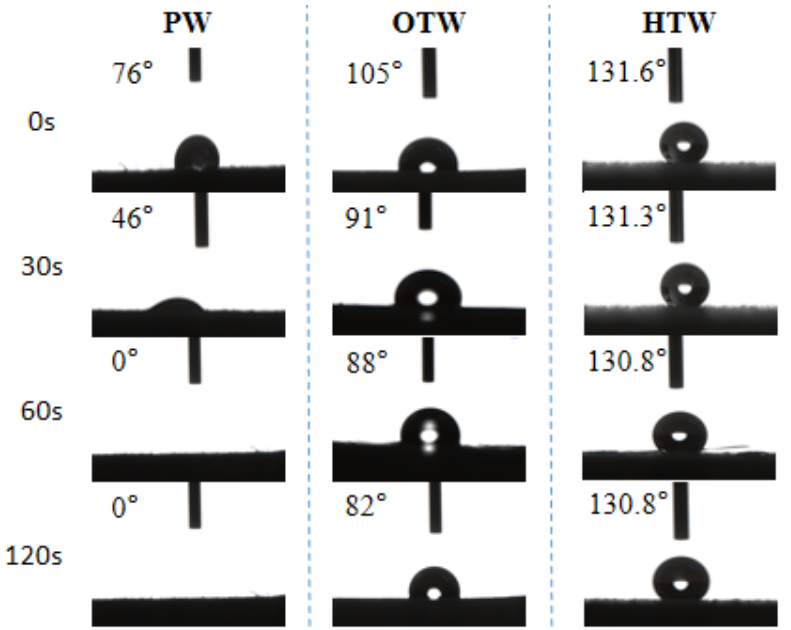
Figure 4. Results of water contact angle for three groups of samples at di ff erent times.